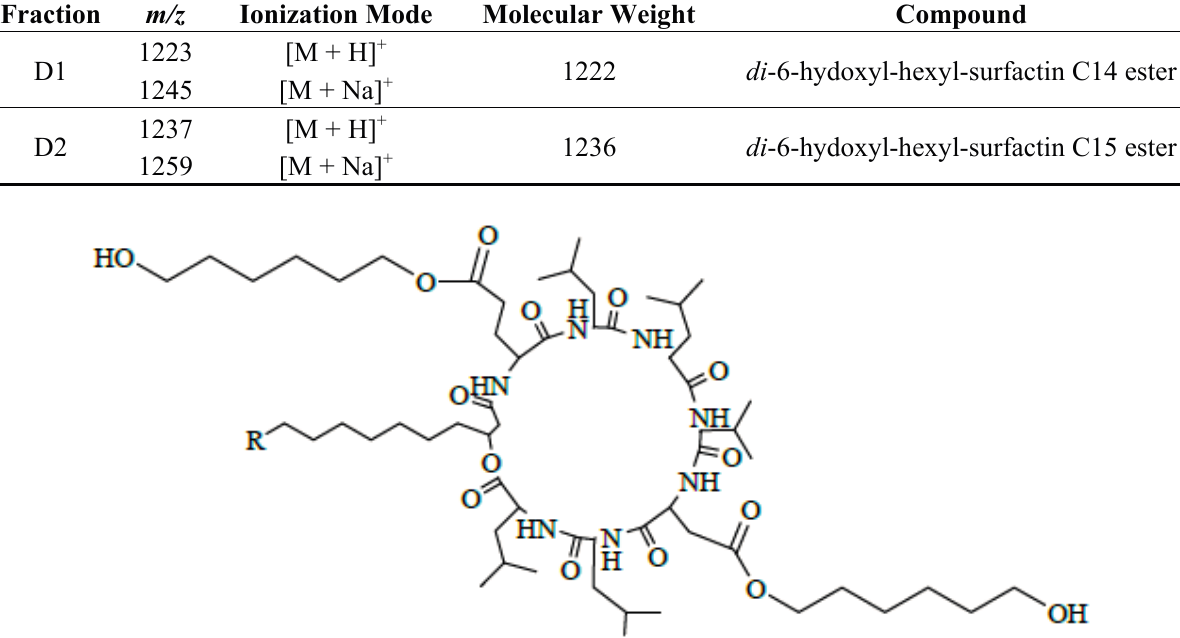
Figure 13. The structures of D1 and D2. D1: R = C 5 H 11 ; D2: R = C 6 H 13